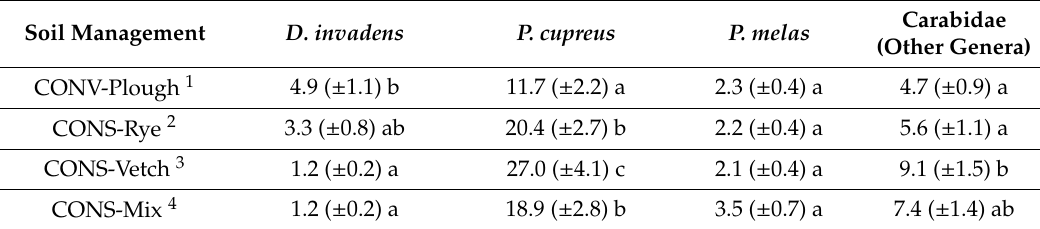
Table 1. Mean catches ( ± SE; n = 156) of D. invadens and ground beetles ( P. cupreus , P. melas and other Carabidae) in trial no. 1 according to di ff erent soil management systems.